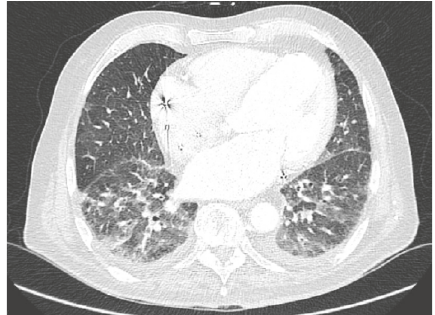
Figure 3: CT chest showing bilateral ground glass opacities consis- tent with congestive heart failure (case